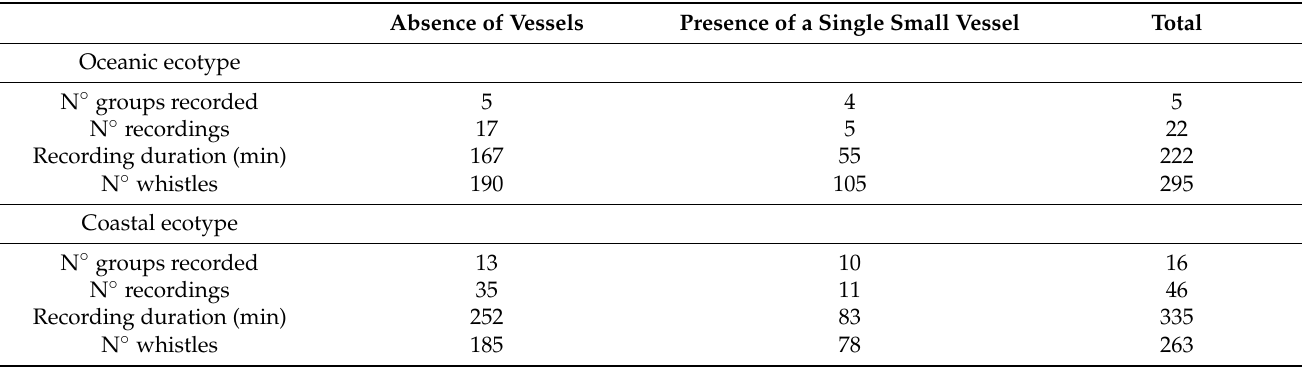
Table 2. Data collection recap table.